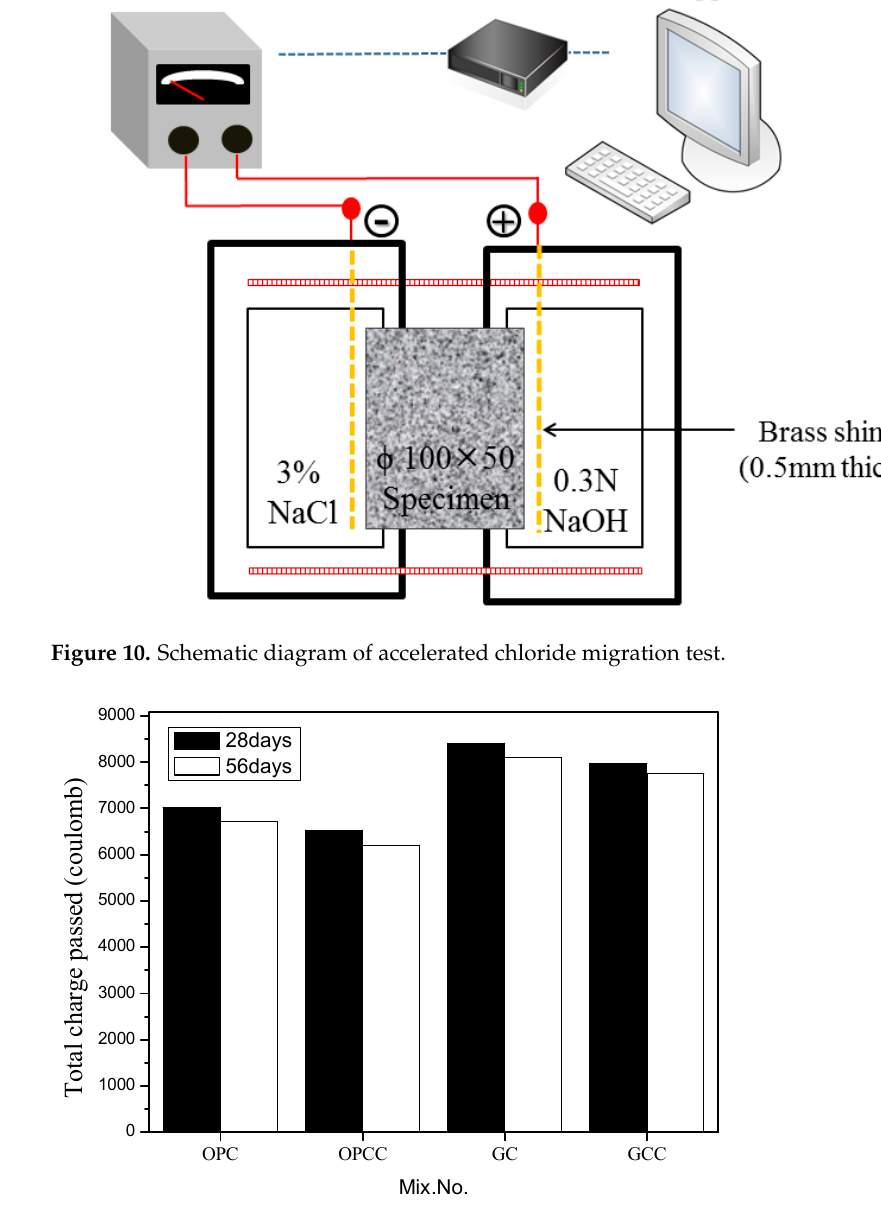
Figure 11. Comparison of cumulative total power supply.